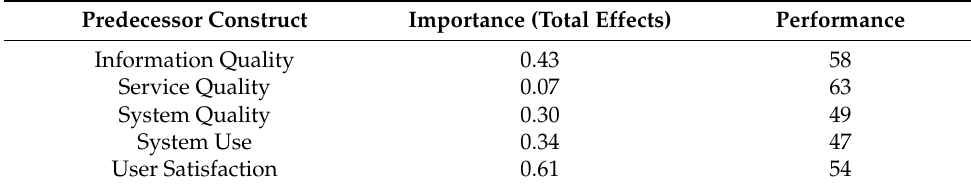
Table 7. Summary of the IPMA for Net Impacts.